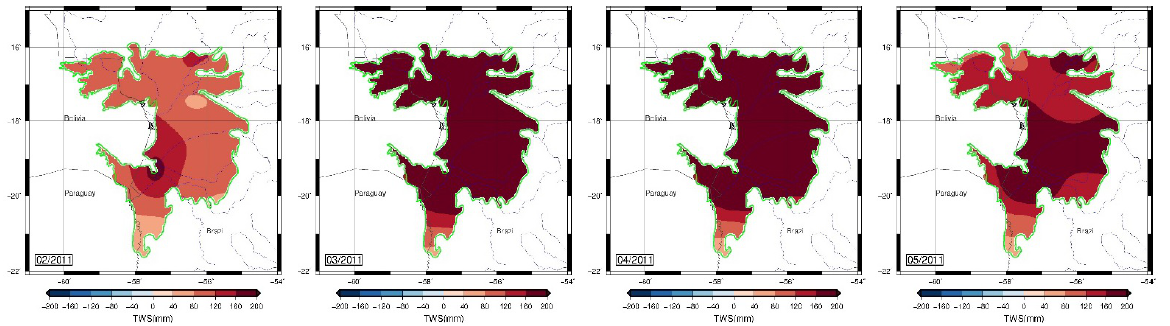
Fig. 4. TWS increase in the Pantanal area (February 2011 to May 2011).